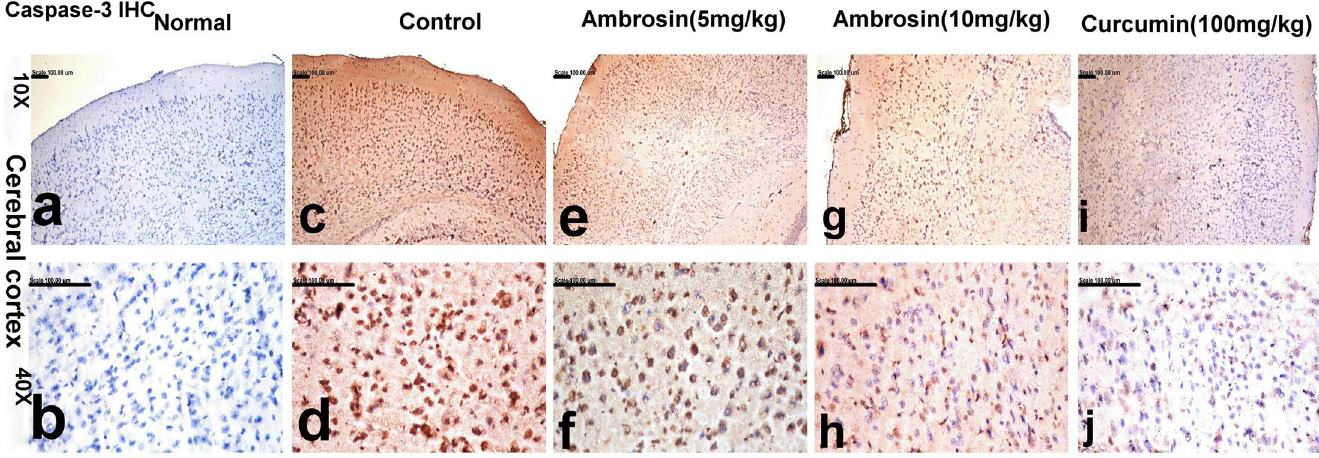
Fig 13. Cleaved caspase-3 immune reactive neurons in the brain sections of mice (magnifications: 10X, 40X). The photomicrograph illustrates the following groups: (a, b) normal mice showing no caspase-3 immune reactive cells, (c, d) control mice showing significant increase of caspase-3 immune reactivity, (e, f) Ambrosin (5 mg/ kg/day) treated mice showing reduction of caspase-3 immune reactivity, (g, h) Ambrosin (10 mg/kg/day) treated mice showing significant reduction of caspase-3 immune reactivity, and (i, j) Curcumin treated mice showing weak caspase-3 immune reactivity. (Cleaved caspase-3 immunohistochemical stain).